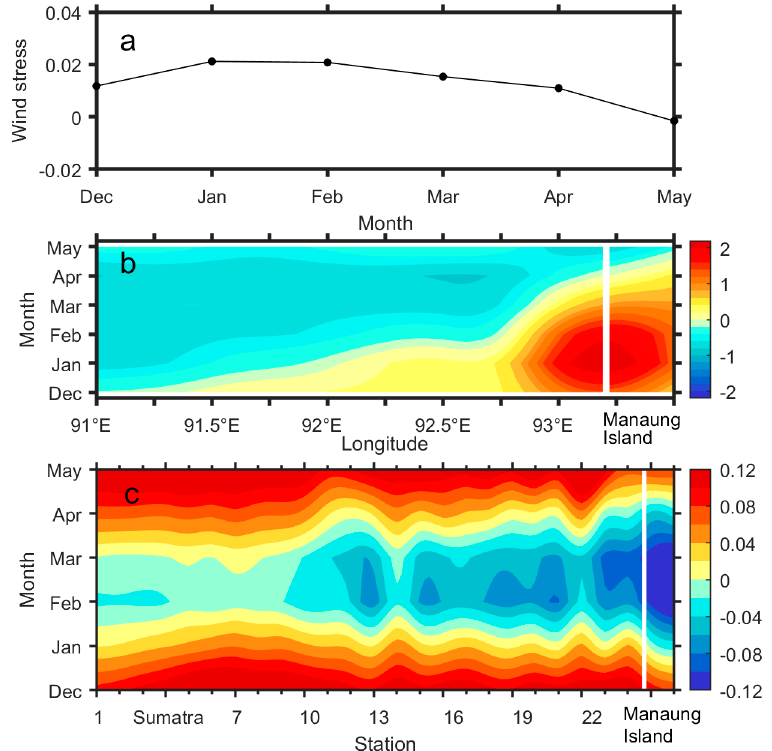
Figure 6. ( a ) Time series of climatological monthly alongshore wind stress of Manaung Island (the southeast direction along the coastline is positive, unit: N m − 2 ); ( b ) Time–Longitude diagram of climatological monthly wind stress curl averaged over area A (unit: 10 − 7 N m − 3 ); ( c ) Time–station diagram of climatological monthly SLA (unit: m). The stations and the range of area A are shown in Figure 1a and 1b, respectively. All climatological monthly mean data is averaged from the daily/6 h data for the period 1993 to 2016.